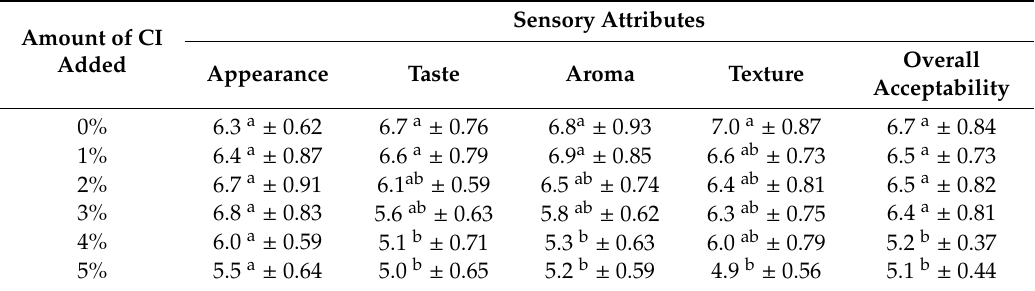
Table 4. Sensory analysis of wheat bread enriched with Cistus incanus L.